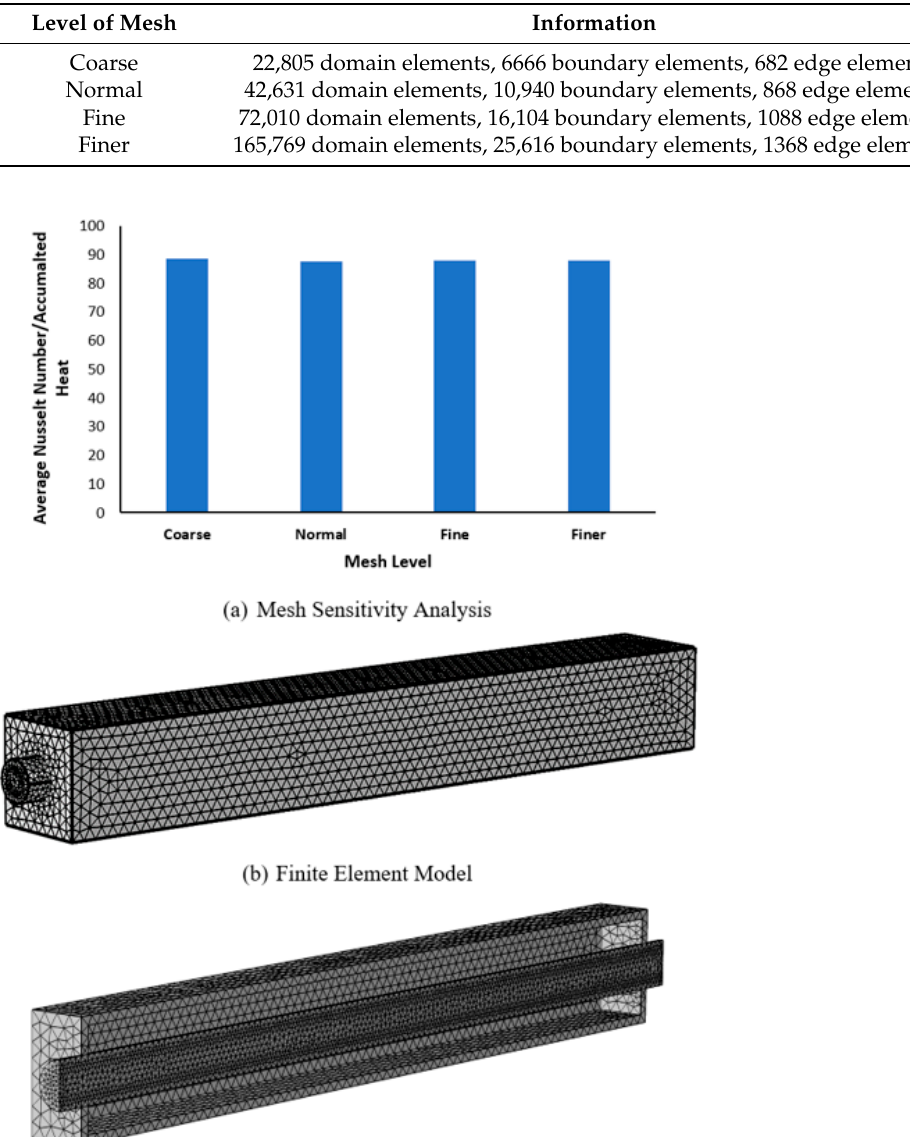
Table 2. Mesh information for different levels of meshing.